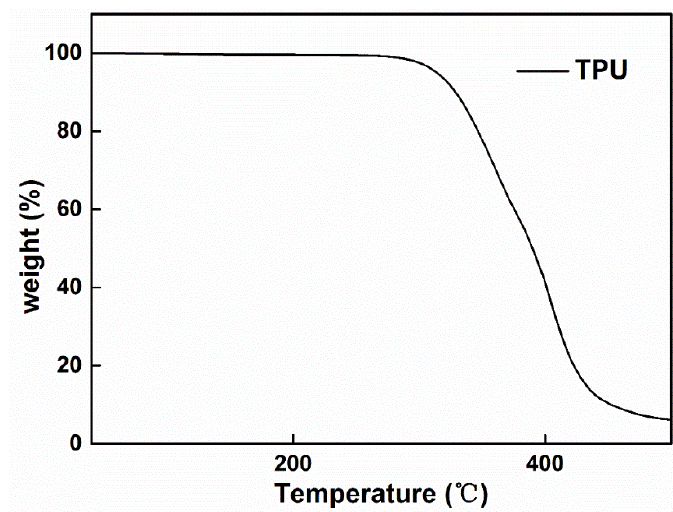
Figure 7. TGA patterns of TPU fibers.